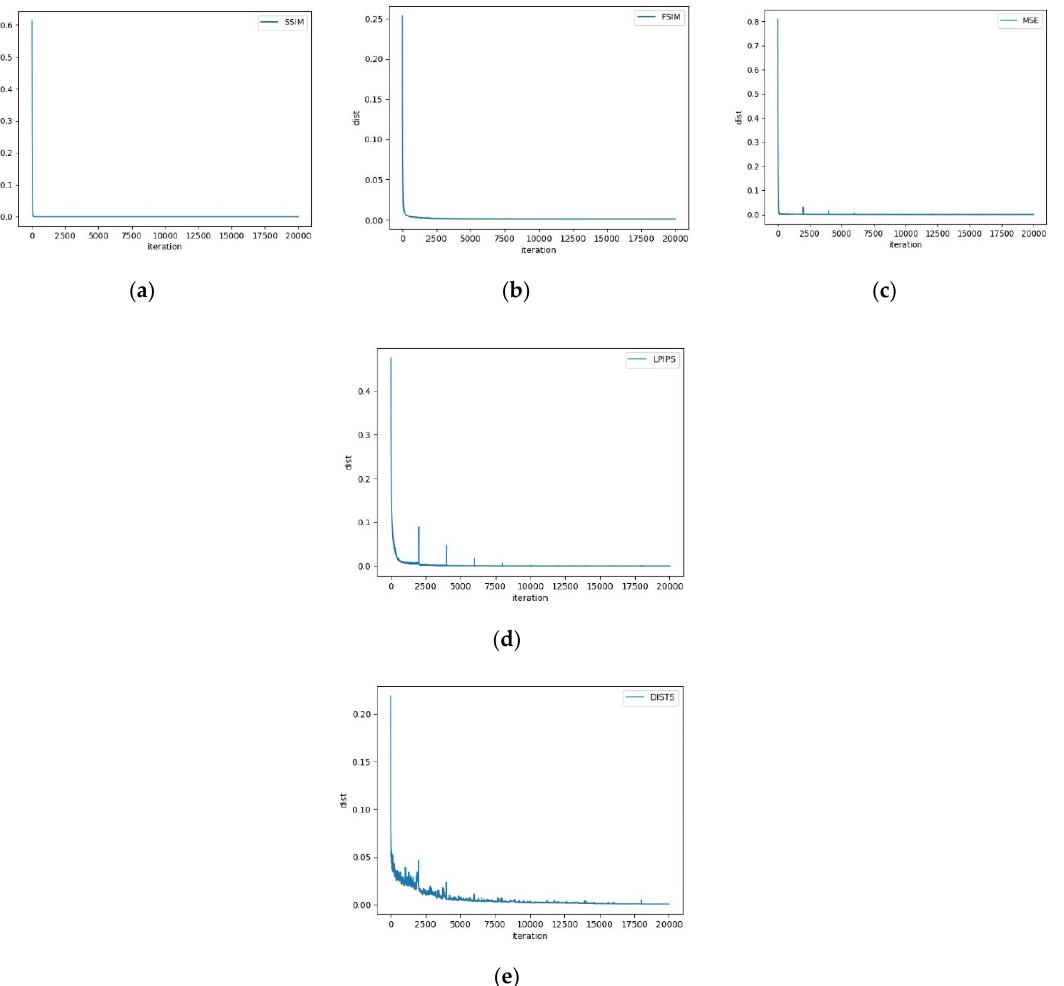
Figure 7. Distorted Gorge recovery obtained by different models at 500, 2000, 10,000 and 20,000 iterations.